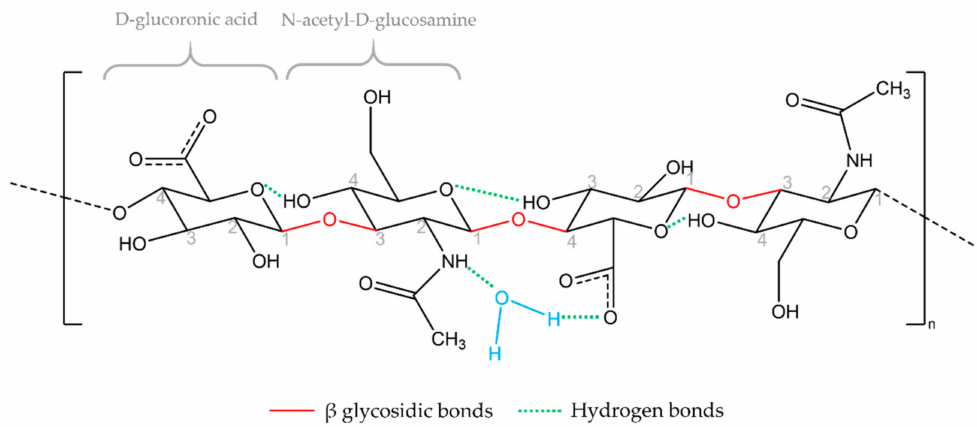
Figure 1. Chemical structure of hyaluronic acid (HA), where the disaccharide units that compose it are shown: D-glucuronic acid and N-acetyl-D-glucosamine. Green is shown by hydrogen bonding, including water bonding, and red signifies glycosidic bonds that occur in the molecule.